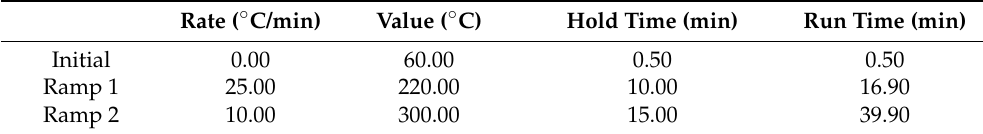
Table 2. Gas chromatography (GC) temperature gradient program parameters in the wide retention window (WRW)